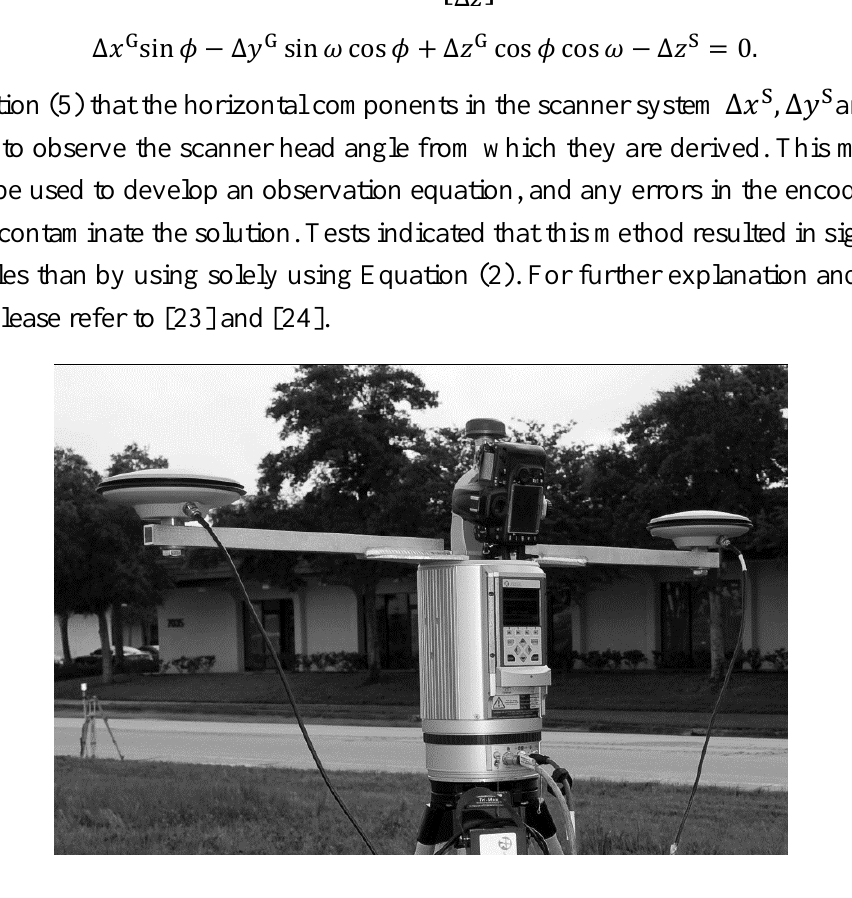
Figure 1. The dual antenna system (DAS) mounted on a Riegl VZ400. Both the GNSS antennas and camera are fixed to the scanner head, which rotates during acquisition, and can rotate on-demand based on user